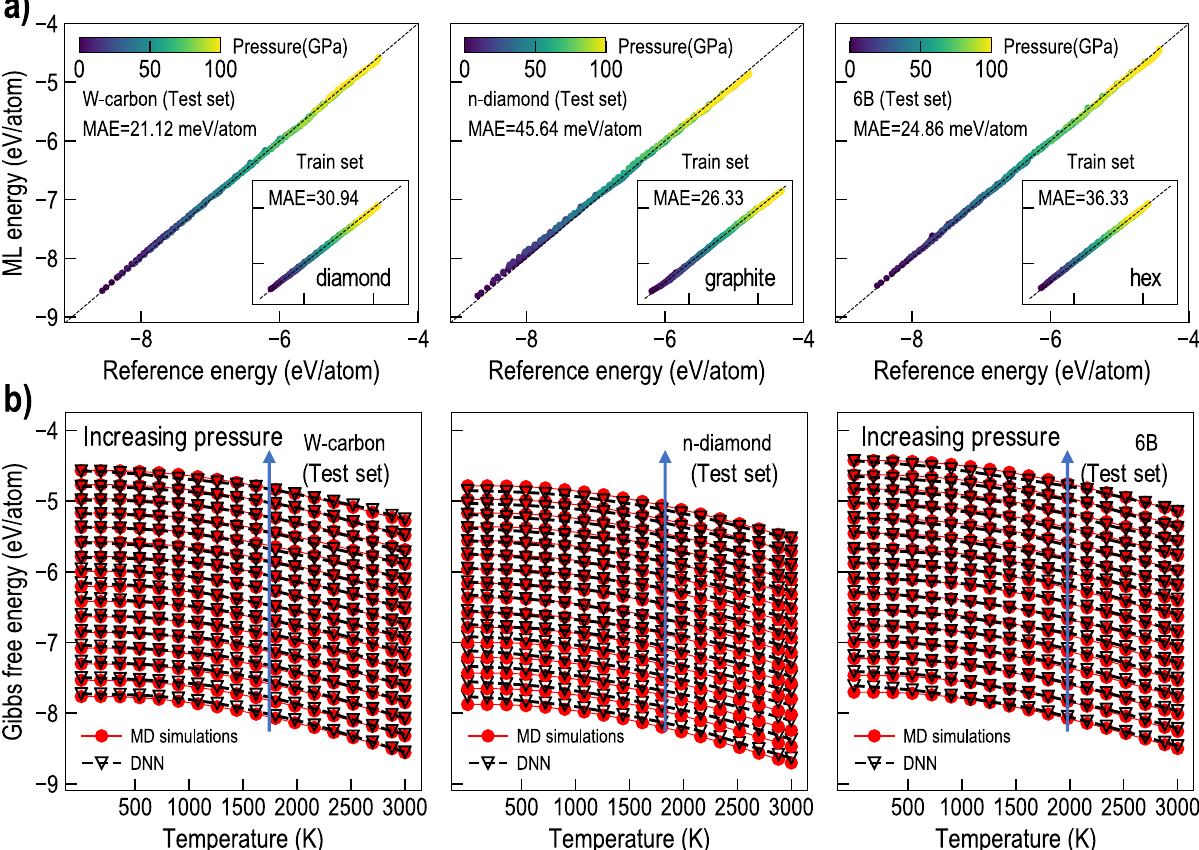
Fig. 5 Performance of the DNN model to predict Gibbs free energy of different phases of carbon. a Parity plot demonstrating prediction accuracy of DNN model against reference Gibbs energy dataset for different phases of C in the test or training set (inset). For better comparison, the range of x- and y-axes is kept consistent in the inset and the main panels. b Gibbs free energy predictions for the W-carbon, n -diamond (291) and 6B (389) phases for various temperature and pressures. Although these phases were part of the test set, DNN predicts their equation of states accurately. The blue arrows in panel ( b ) indicate the direction of increasing pressure. Abbreviation: MAE, mean absolute